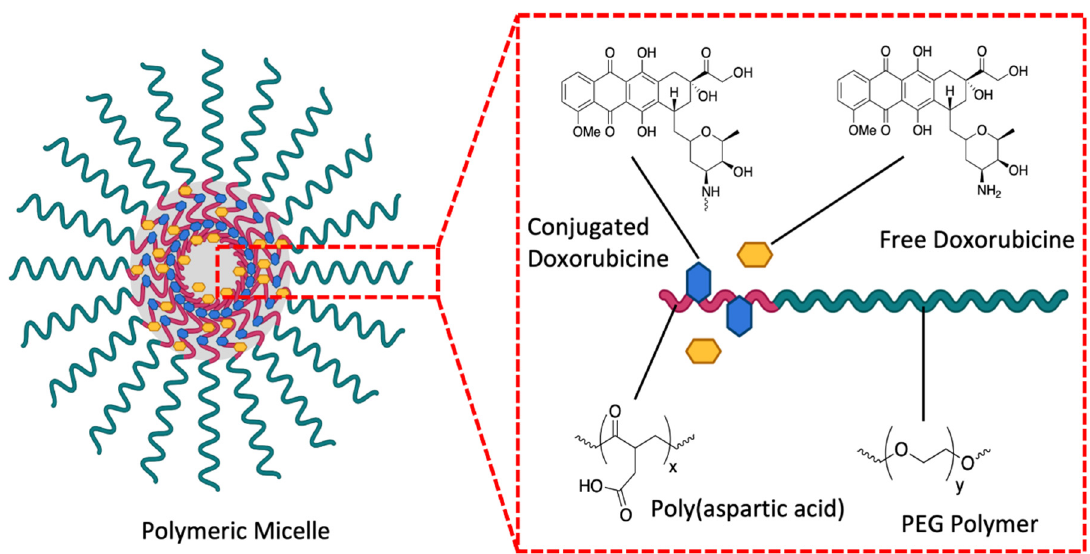
Figure 12. Schematic structure of NK911. A polymeric micelle composed of a copolymer block of PEG and polyaspartic acid (about 30 units). The polyethylene glycol is located at the outer level of the shell of the micelle. NK911 has a very hydrophobic heart, which allows it to capture a sufficient amount of doxorubicin (created with Biorender; adapted and modified from [170], Br J Cancer, 2004.